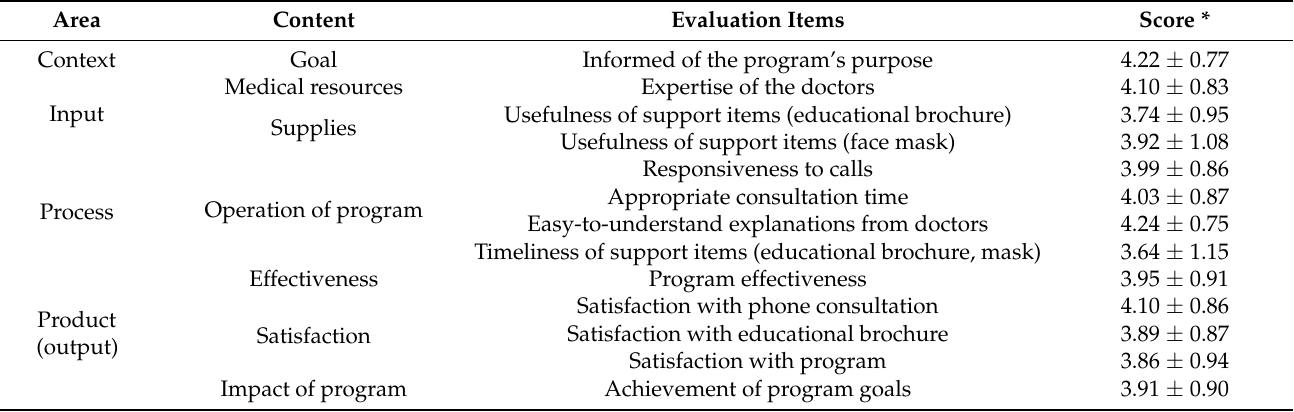
Table 5. Sub-area evaluation of the Follow-up Health Consultation Program by recovered patients.